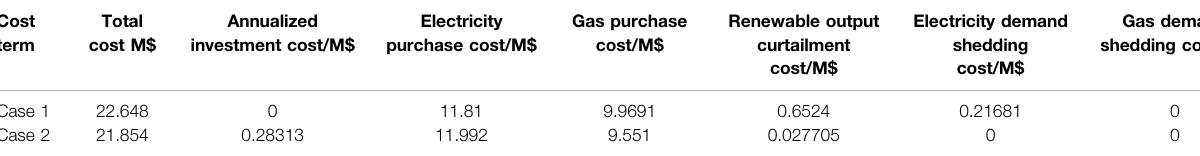
TABLE 2 | Comparison of planning and operation costs.